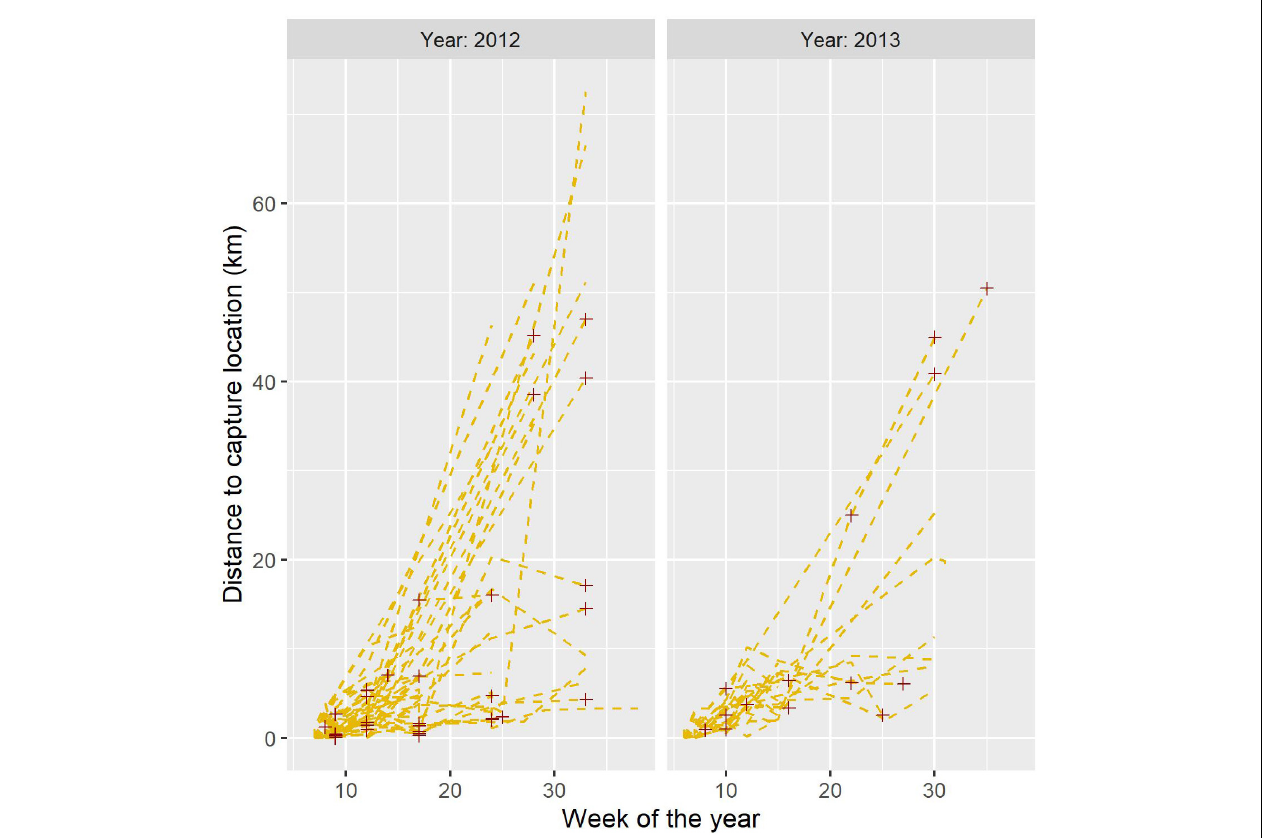
FIGURE 3 | Linear displacement from the capture site plotted agains week. Each line represent the trajectory for one individual bird ( n = 82 birds, for which we had at least two positions), and red crosses indicates death